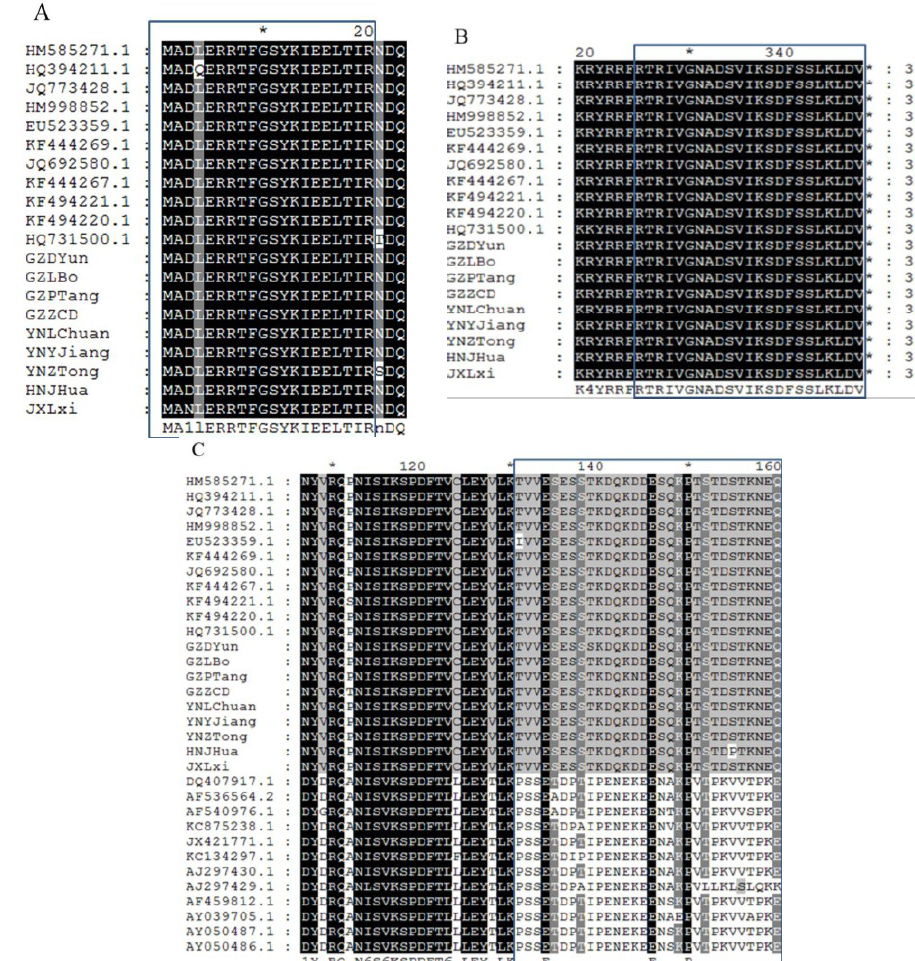
Figure 2. Alignments of SRBSDV-P9-1 and RBSDV-P9-1 by Gene Doc software. ( A ) Highly conserved N- terminal residues deduced by the alignment of 11 SRBSDV-P9-1